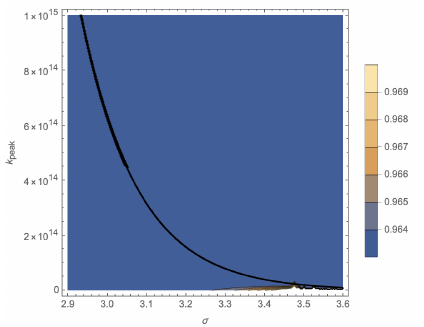
Figure 2. The impact of Equation (38) on the parameters of our model for 10 11 Mpc − 1 k peak ≤ 10 12 Mpc − 1 (on the left) and for 10 12 Mpc − 1 ≤ k peak ≤ 10 13 Mpc − 1 (on the right) in the ( σ , k peak ) - plane. The (excluded) area above the black curve leads to the right end of the peak after the end of inflation. The other parameters are P 0 = 6.57 × 10 − 13 and k final = 7.7 × 10 23 Mpc − 1 .